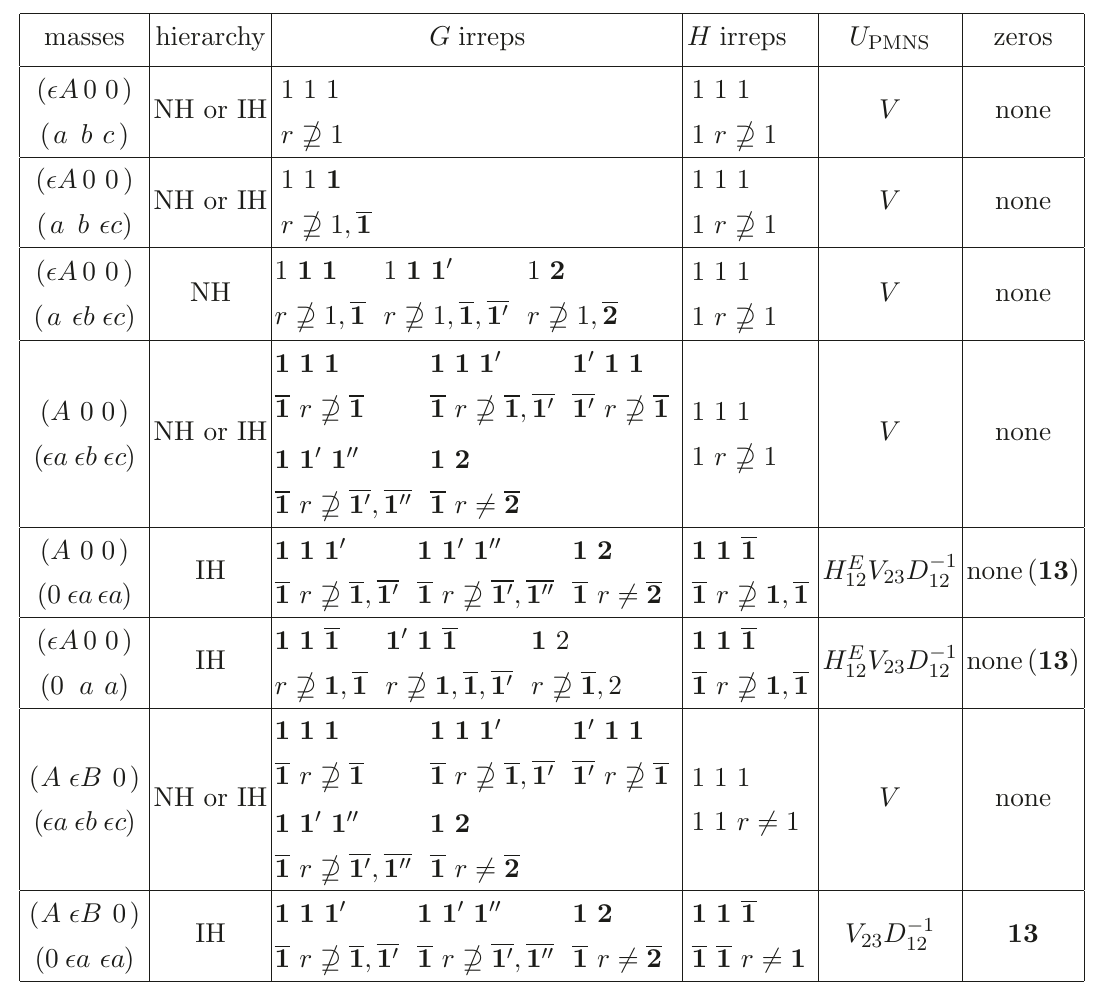
Table 5 . Lepton mass patterns that can be obtained starting from a symmetric limit ( ǫ = 0) in which either the neutrino or the charged lepton masses (but not both) vanish. The corrections proportional to ǫ are induced by the spontaneous symmetry breaking G introduced in section 3. The corresponding irrep decompositions of U G to a viable form of the PMNS matrix are also shown. As usual, boldface fonts denote complex or pseudoreal (if 2-dimensional) irreps, primes are used to distinguish inequivalent representations, and in the case of complex representations 1 ′ is supposed to be different from both 1 and 1 . The representations of G and H are of course different even if represented by the same symbol. If ǫ is reabsorbed into the parameter it multiplies, the mass pattern correspond to the ones in the first four lines of table 4 and the irrep decompositions of U H